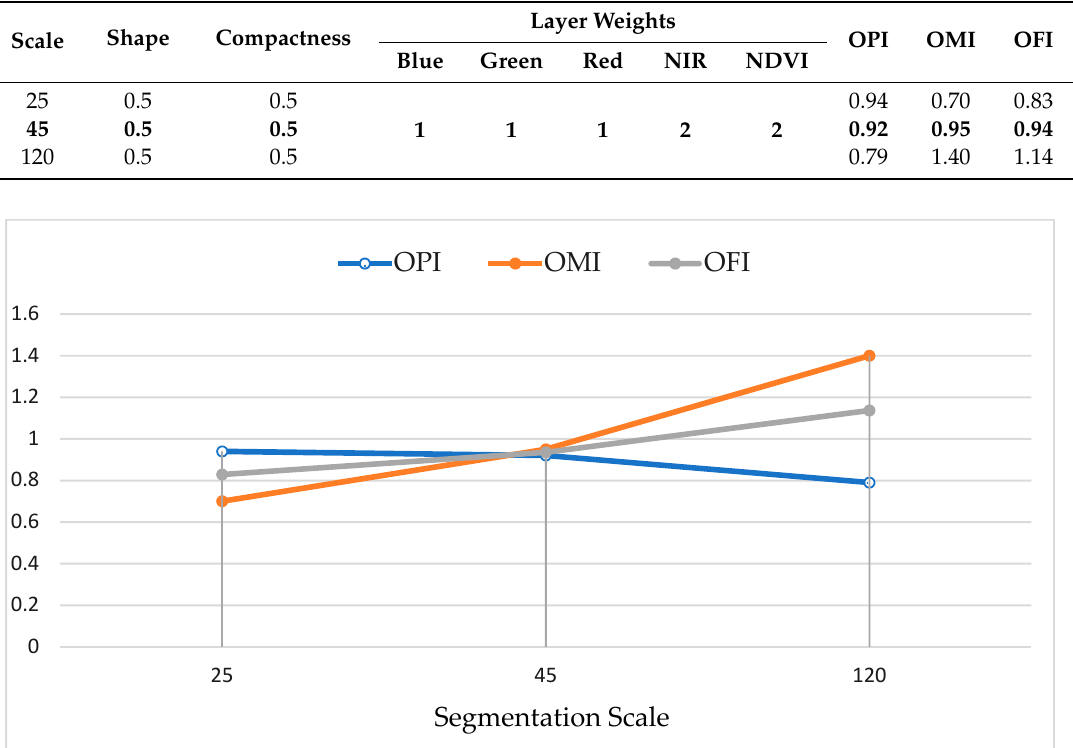
Table 1. Segmentation parameters (optimal scale parameters are in bold) and the results of object evaluation indexes.